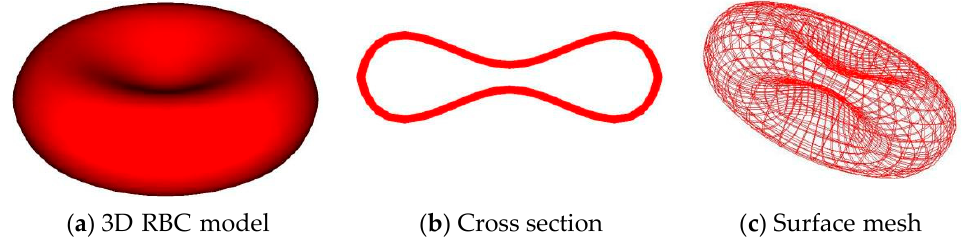
Figure 1. A three-dimensional finite element mesh of a single RBC